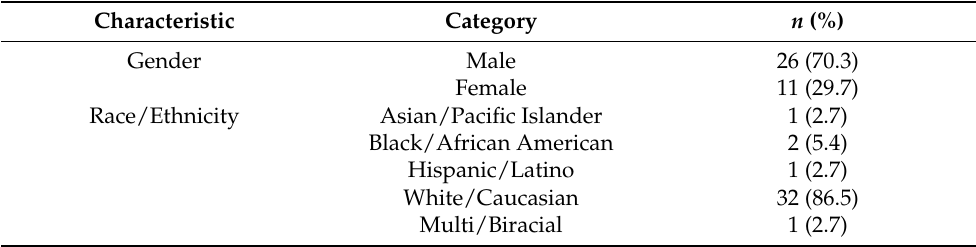
Table 1. Participant characteristics ( N =